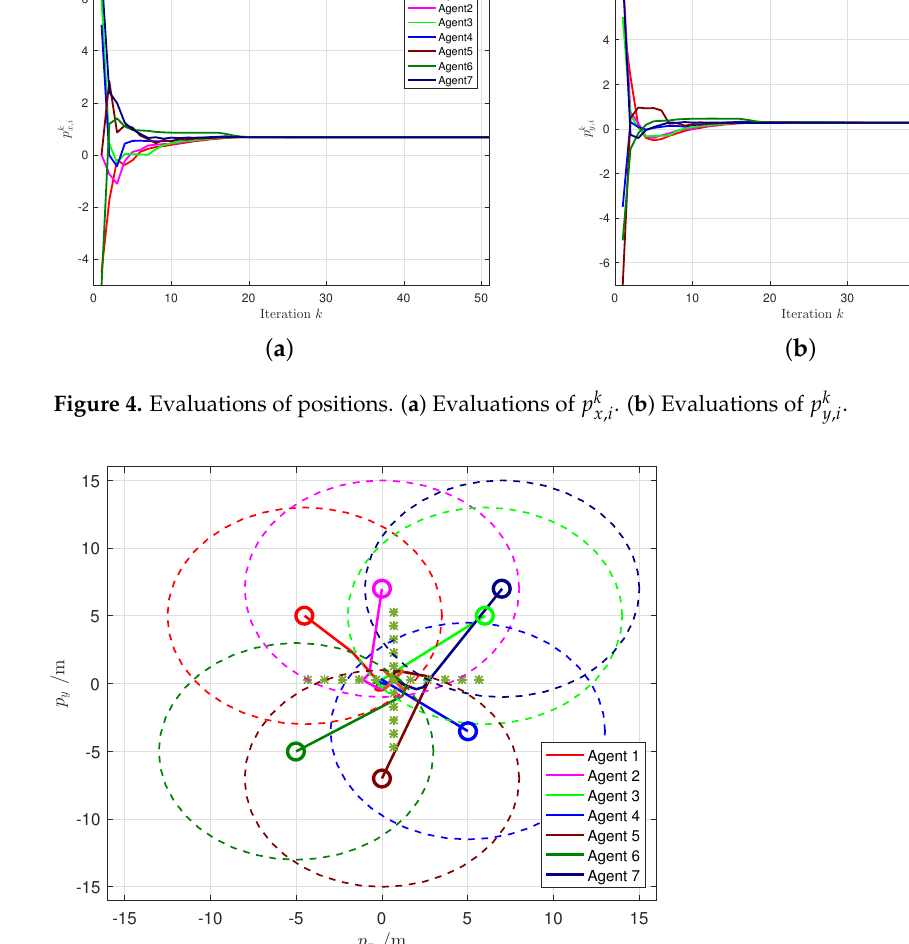
Figure 5. Motions of all agents in the 2-D